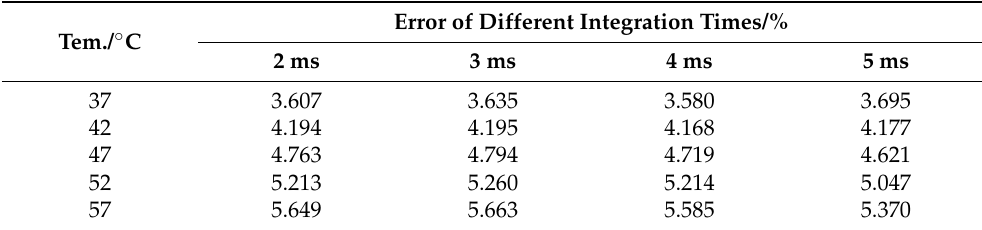
Table 6. Inversion errors of different integration times between the ECCF method and the actual value.